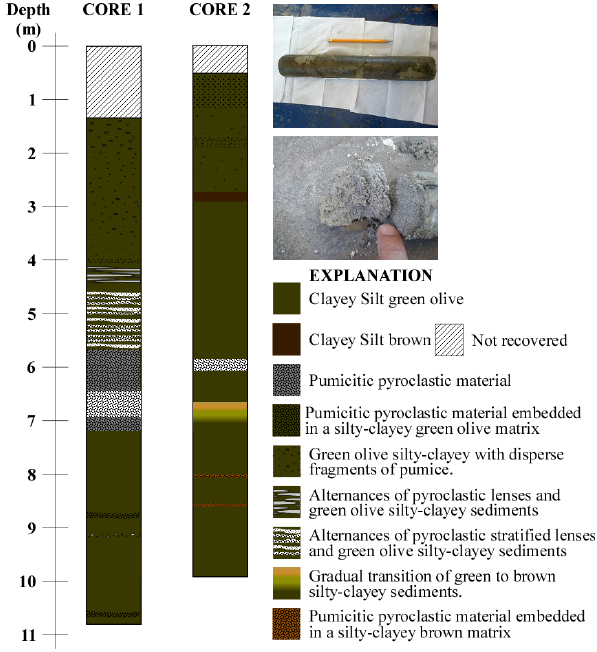
Figure 3. Described stratigraphy of both cores. Sample pho- tographs of the predominant green-olive sediments, along with an example of a pumice sandy layer are